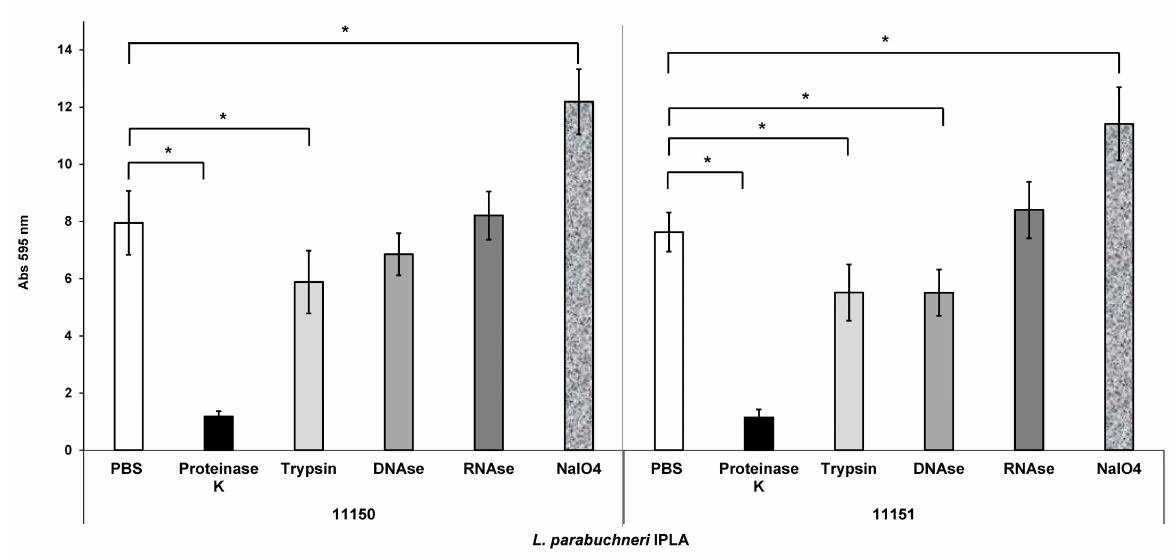
Figure 2. Effect of proteinase K, trypsin, DNAse I, RNAse and NaIO 4 on biofilms produced by the strong biofilm producers L. parabuchneri IPLA11150 and IPLA11151. The strains were incubated for 48 h at 37 ◦ C and subjected to treatments with the stated agents for 24 h. Data represent means ± SD (error bars) of three experiments. Values marked with * differ significantly.